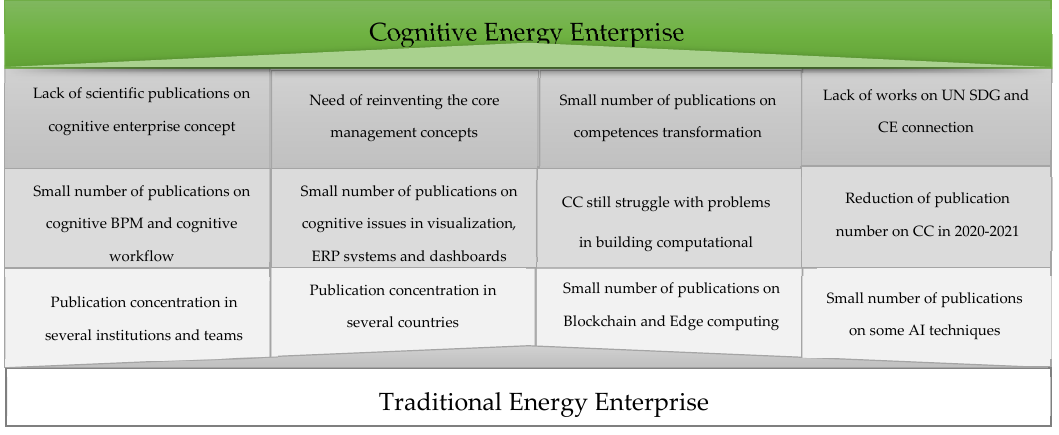
Figure 8. Research milestones in the transformation of energy enterprises into the cognitive enterprises (own preparation based on [32]).